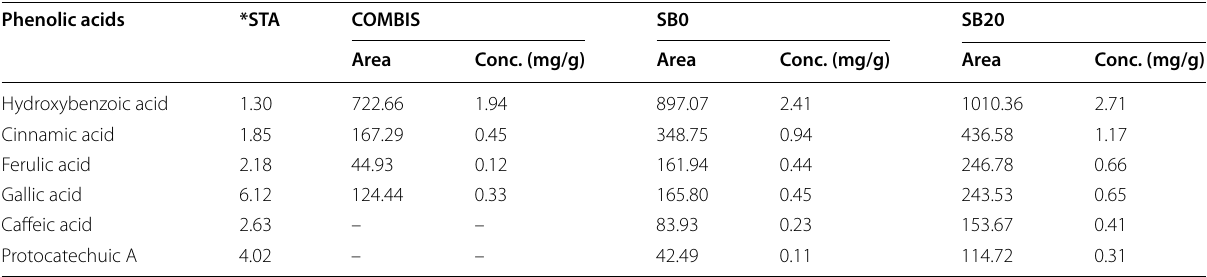
COMBIS: Commercial onion biscuit; SB0: 100% Plantain biscuit, SB20: 80% Plantain